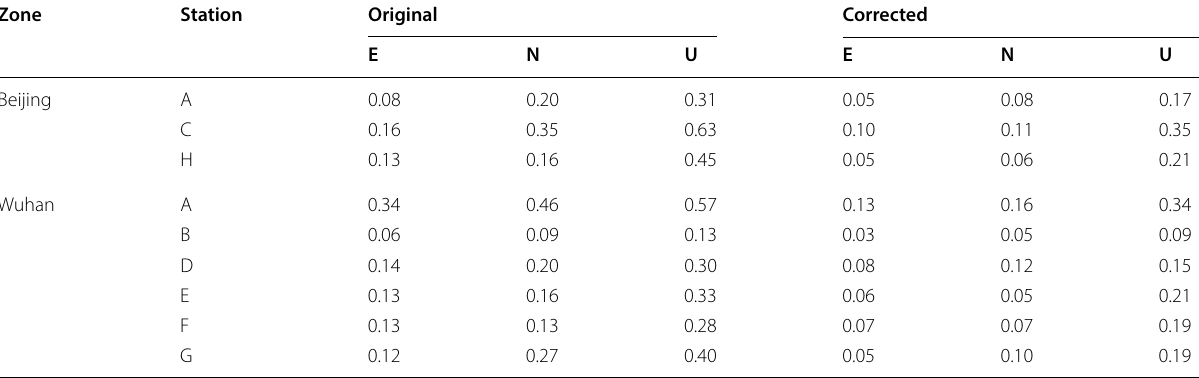
Table 2 Positioning results with and without the orbit error fluctuations correction (unit: m)